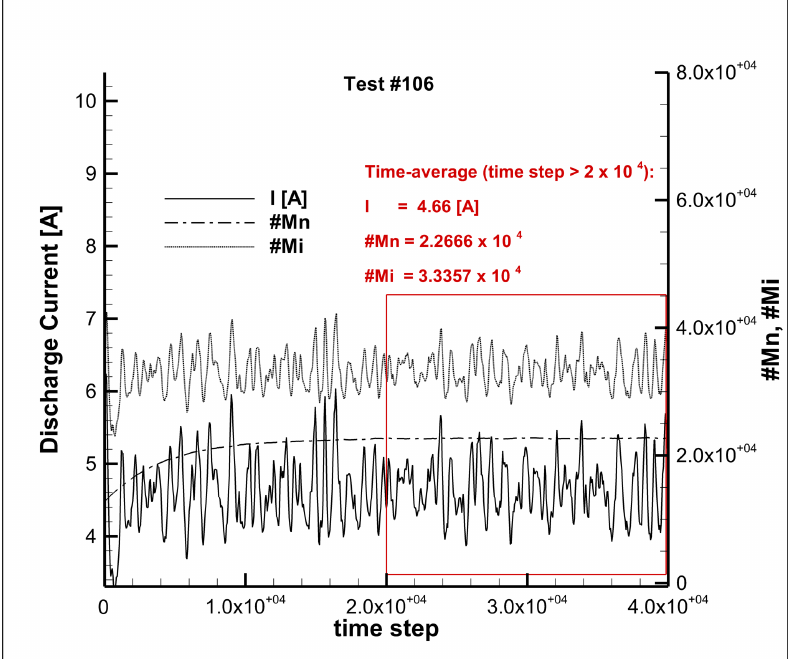
Figure 11. Test 106 Number of followed heavy particles (neutrals, Mn and ions, Mi) and discharge current as a function of time step number. Sampling: 50 time steps. Time step: ∆ t = 5 × 10 − 8